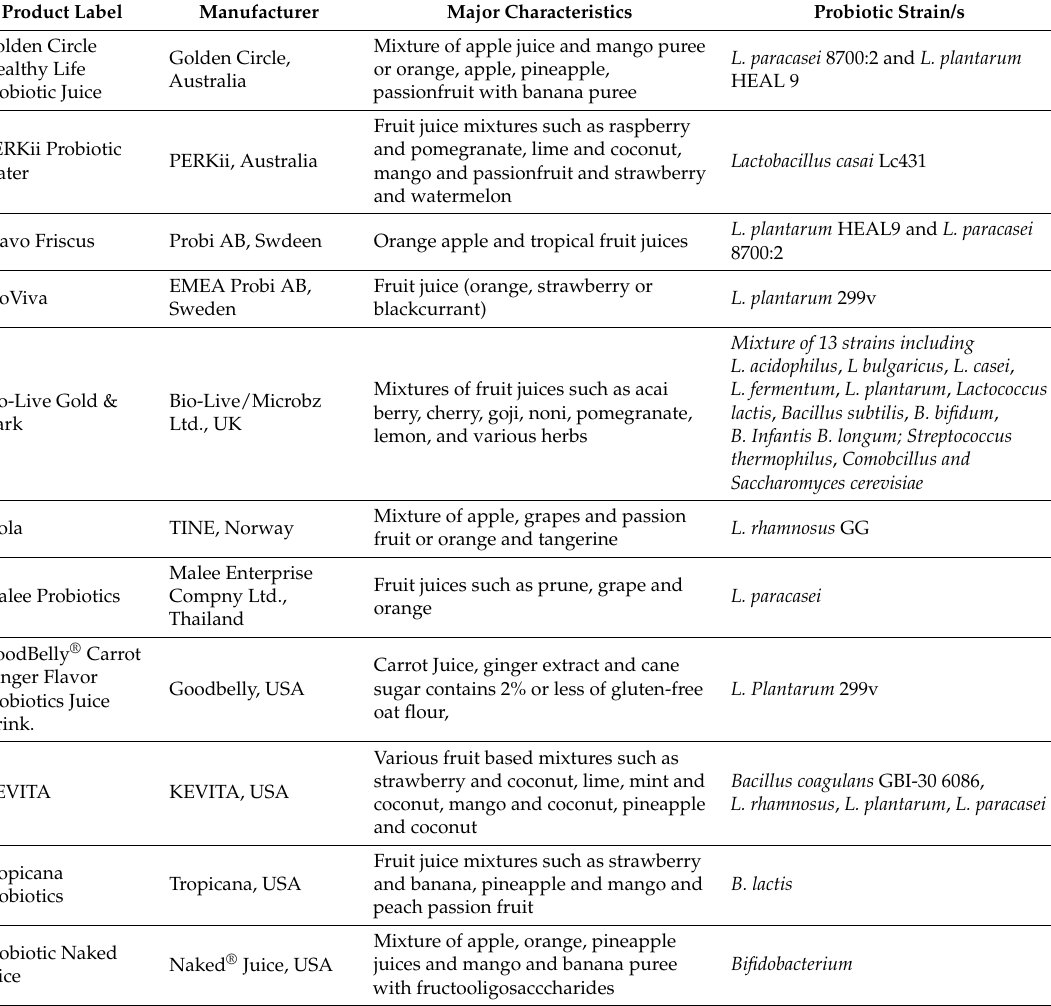
Table 5. Commercially available non-dairy probiotic